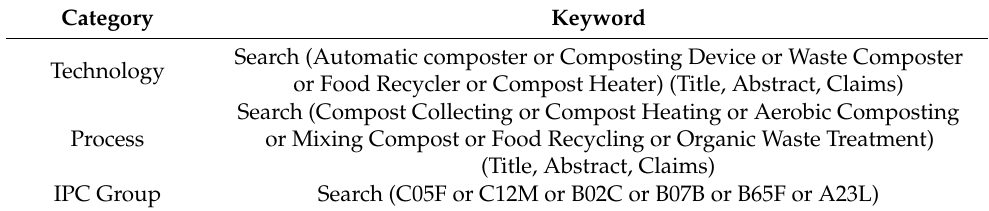
Table 5. Keywords used in the patent search.